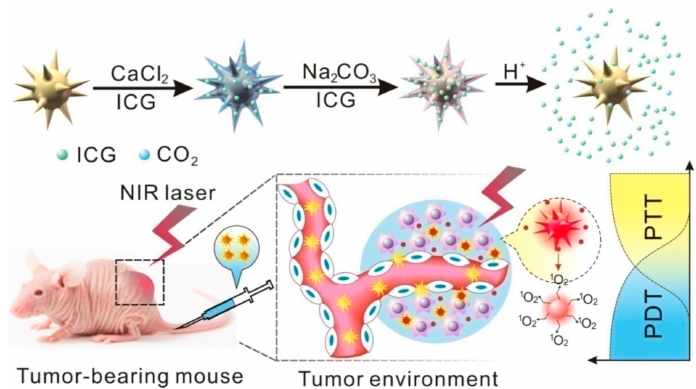
Figure 13. Scheme of construction and release mechanism of pH-trigger release system. Reproduced from [102] with permission from Ivyspring International Publisher.